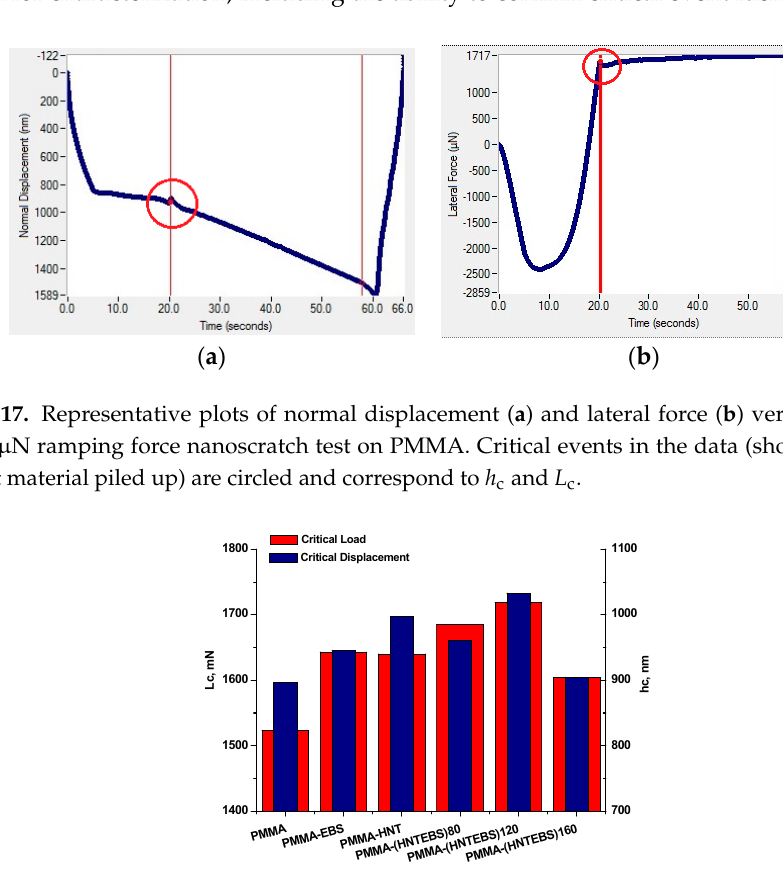
Figure 18. Plots of L c and h c data from 5000 µ N ramping force nanoscratch tests on PMMA and PMMA/HNT nanocomposites.